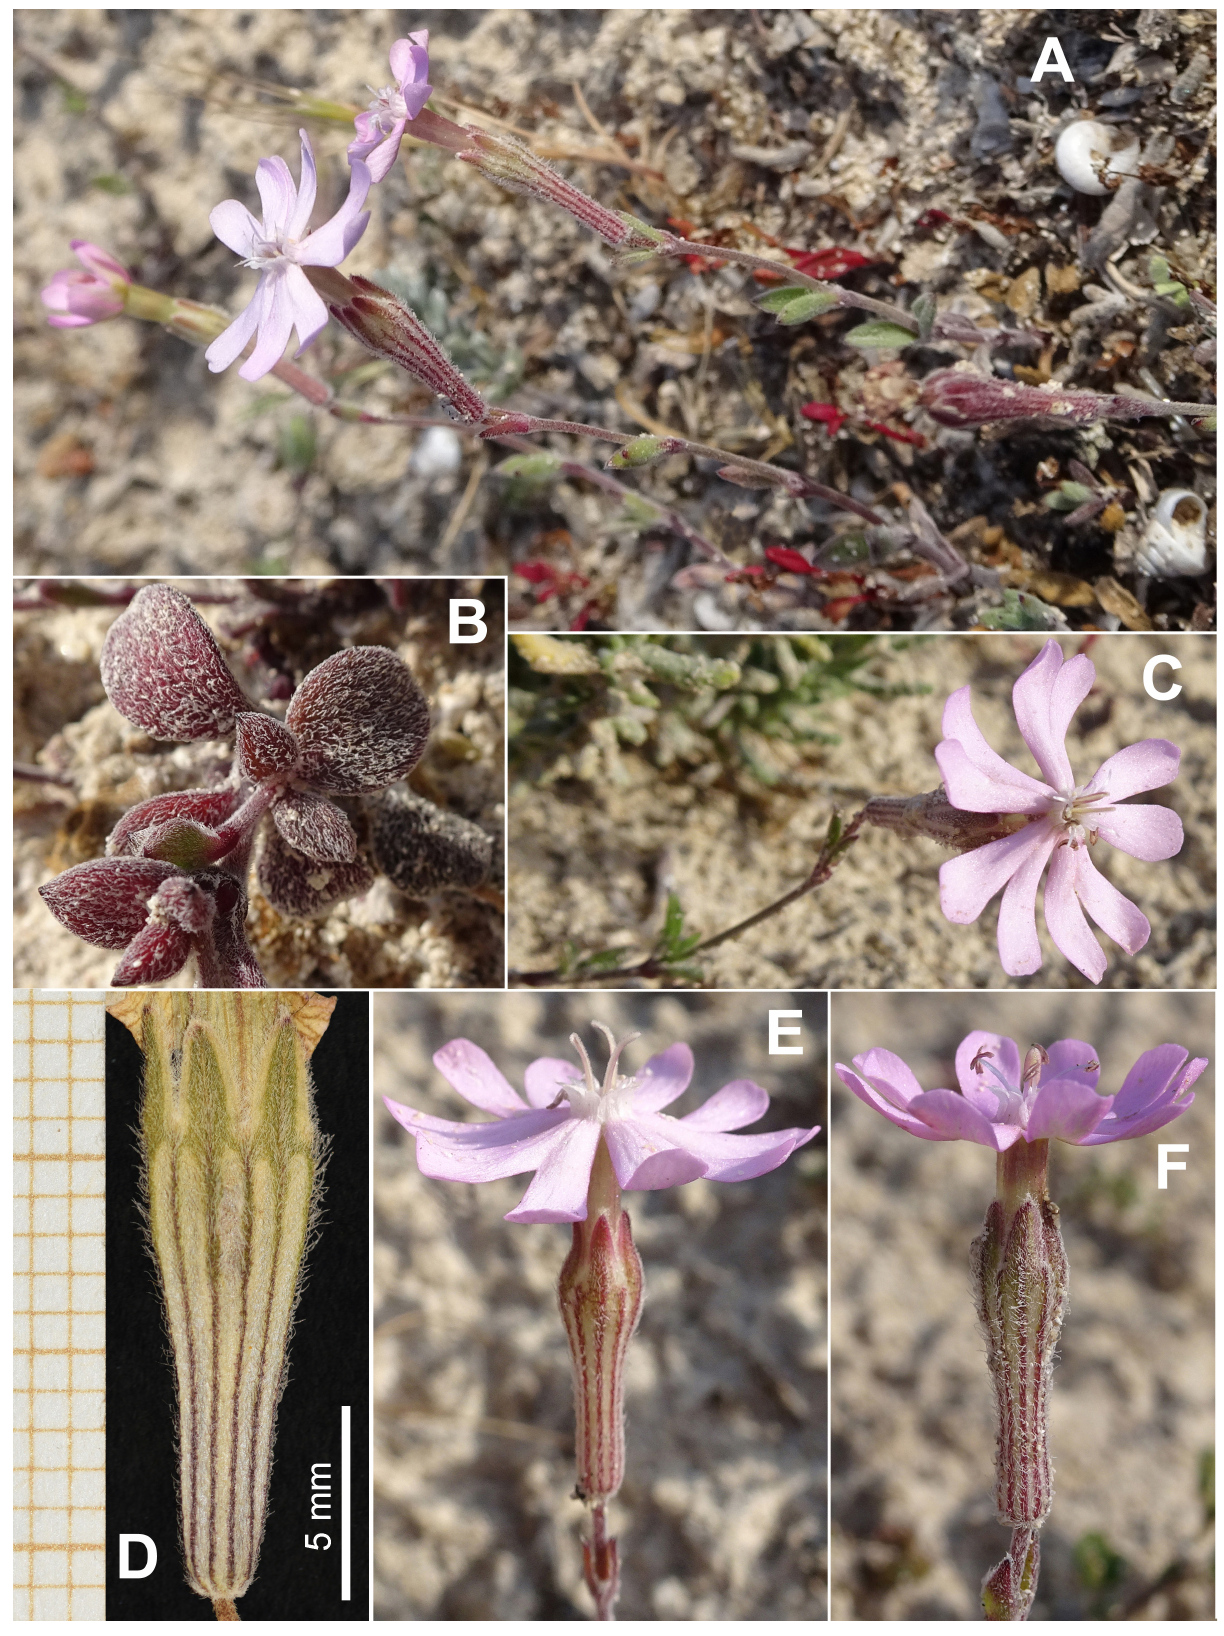
Figure 2. Silene migjornensis . A: Habit. B: Leaves. C-F: Flower (Field photographs taken by E. Guasp in Mallorca, Es Trenc, 16 April 2019). D: Calyx of a herbarium specimen from the same location (L. Sáez, herb. pers., no.